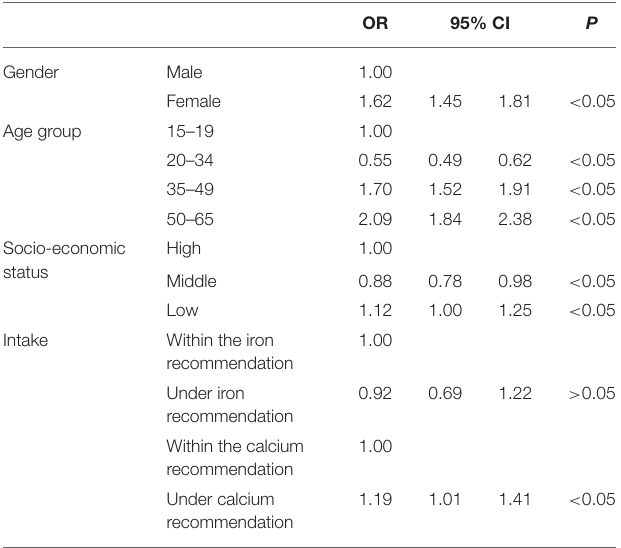
TABLE 3 | Association between the main characteristics of the subject and obesity in the Latin American Study of Nutrition and Health (ELANS). OR 95%